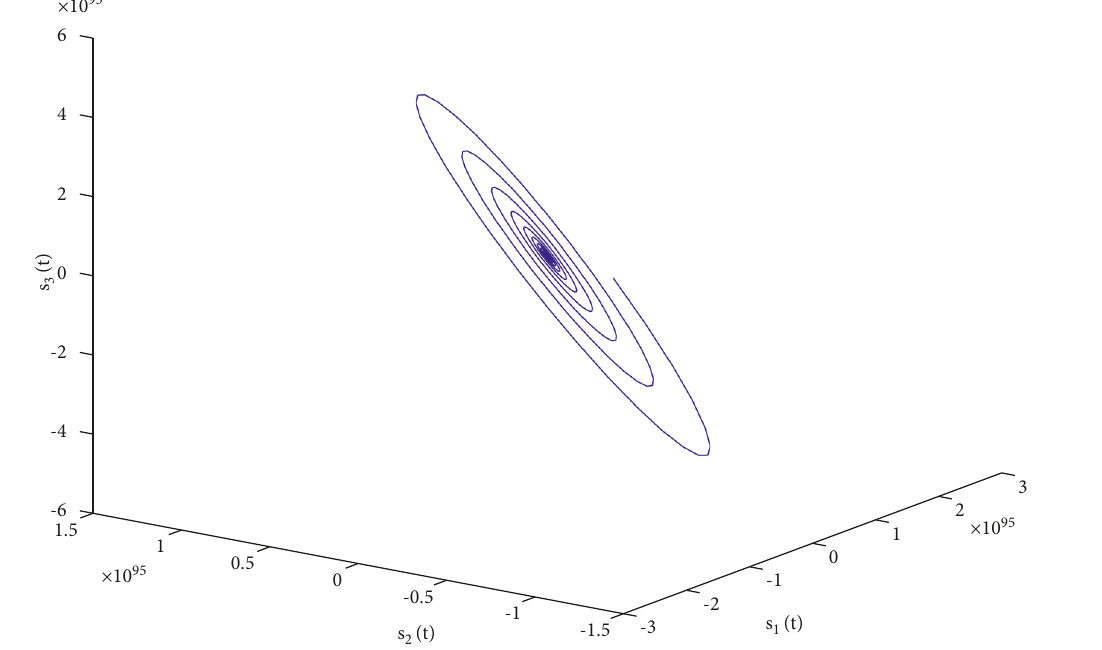
Figure 1: State trajectories of the Chua’s system with the given initial condition s ( 0 )